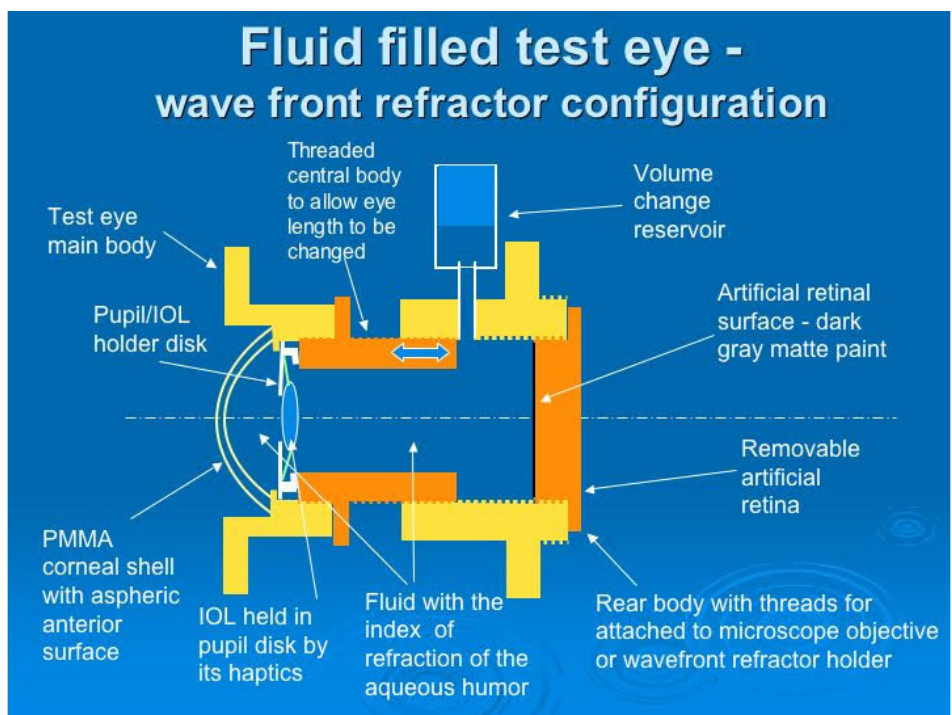
Figure 1. A cross-sectional view of the eye model used by Campbell. The IOL being tested is shown suspended from its haptics in the pupil disk just as it is in a human eye. Journal of Refractive Surgery 2008;24(3):308–311([28]). Originally published by and reprinted with permission from SLACK Incorporated.